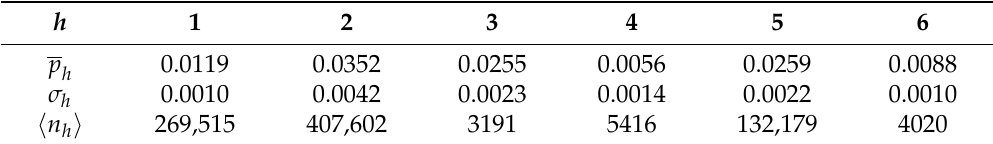
Table 3. Main features of the considered historical time series over the period 1 January 2013 to 31 December 2017. p ( h = 1, . . . ,6) is the yearly average bad loan rate; σ h is the volatility associated to h each p ; (cid:104) n h (cid:105) is the average number of borrowers. h h 1